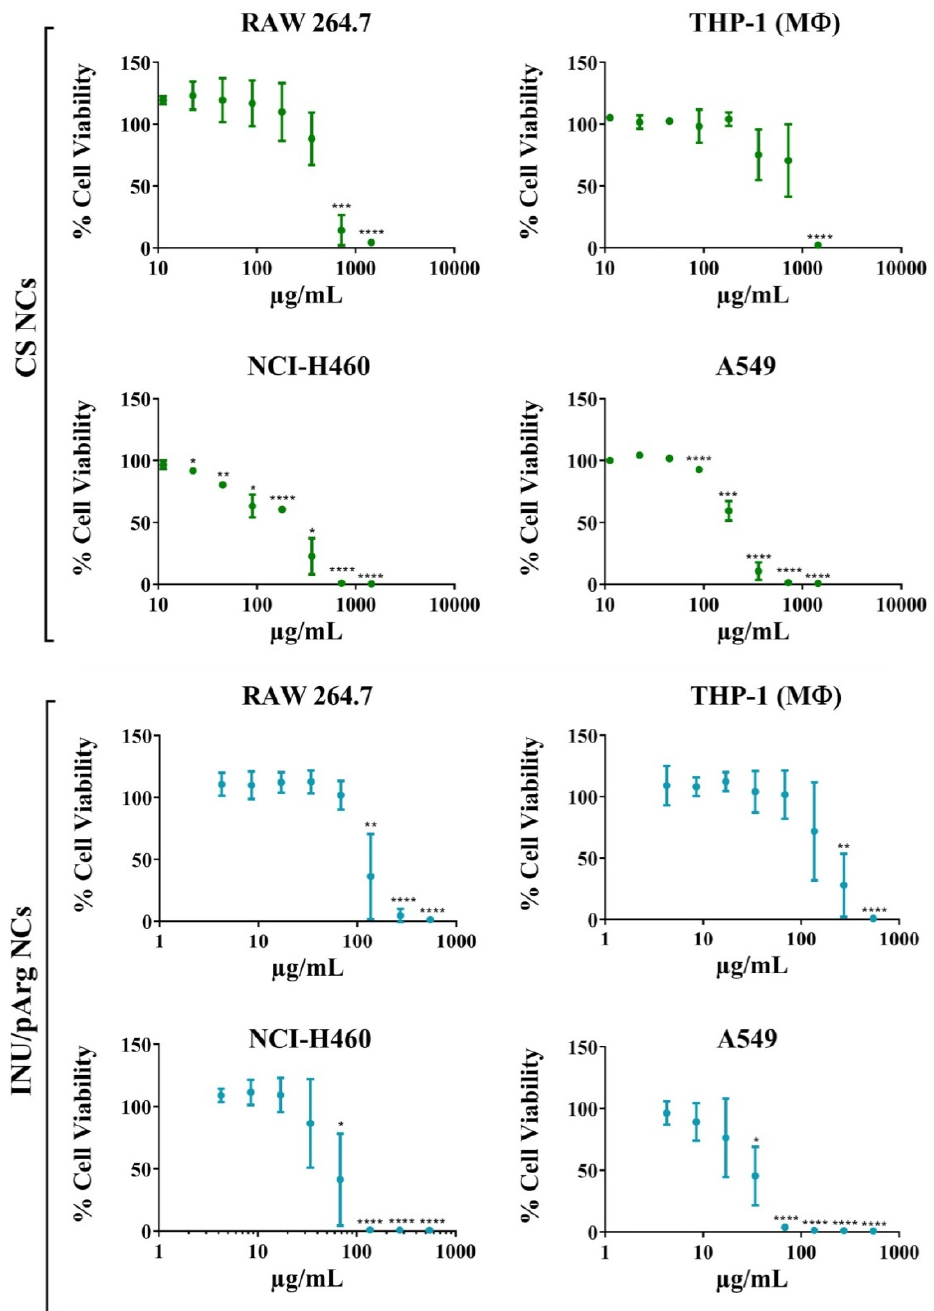
Figure 4. Percentage of cell viability of RAW 264.7, macrophage-di ff erentiated THP-1, NCI-H460, and A549 incubated with di ff erent concentrations of CS and INU / pArg nanocapsules for 24 h. CS: Chitosan, INU: Inulin, pArg: Polyarginine. Statistical significance: * P ≤ 0.05, ** P ≤ 0.01, *** P ≤ 0.001, **** P ≤ 0.0001.